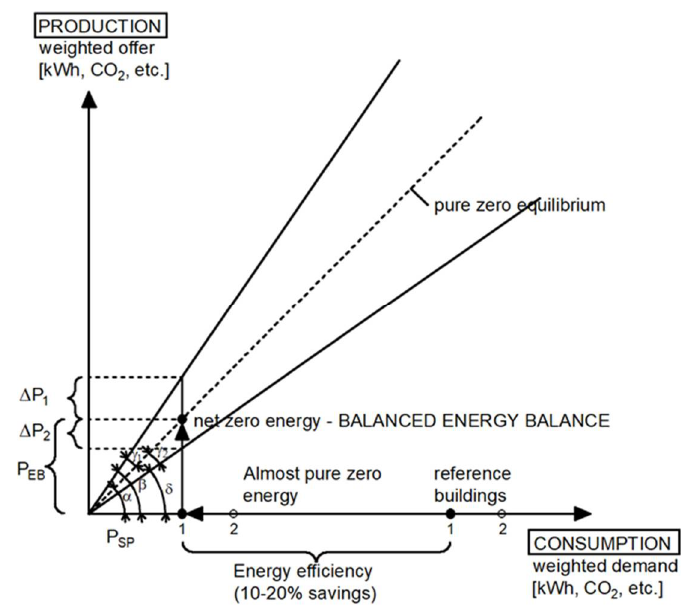
Figure 7. Load fluctuations.